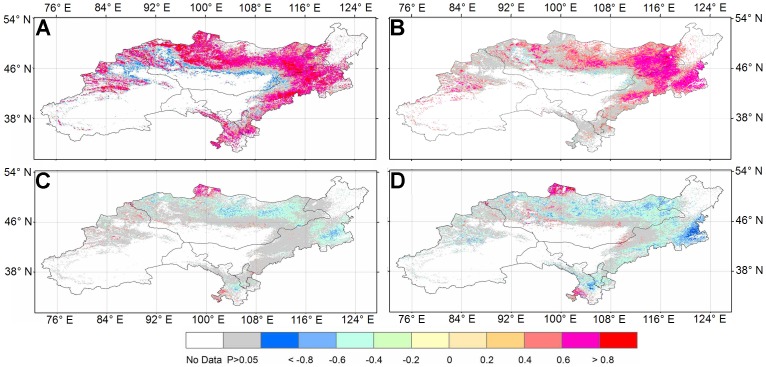
The correlation coefficients between mean annual evapotranspiration and NDVI of growing season (A), mean annual GPCP precipitation (B), mean annual temperature (C), and annual solar radiation (D).The grids with insignificant correlations were marked in gray, and other colors indicate significant correlations (p<0.05).